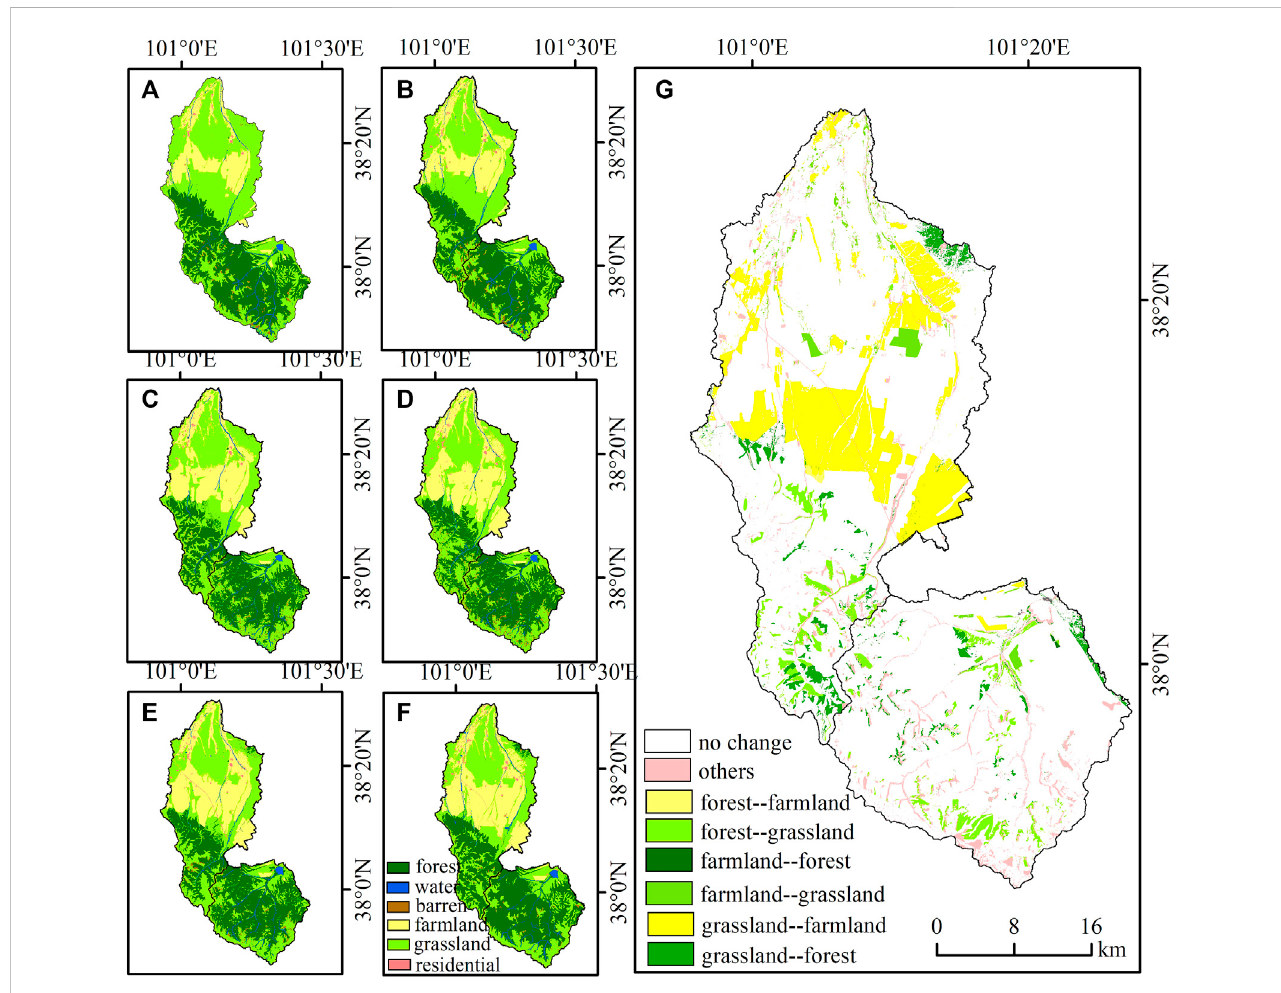
FIGURE 3 Distribution of land use and major land use conversions during 1975 – 2019 in the MYC and XDC (A) , 1975; (B) , 1985; (C) , 1995; (D) , 2005; (E) , 2015; (F) , 2019; (G) , major land use conversions from 1975 to 2019.